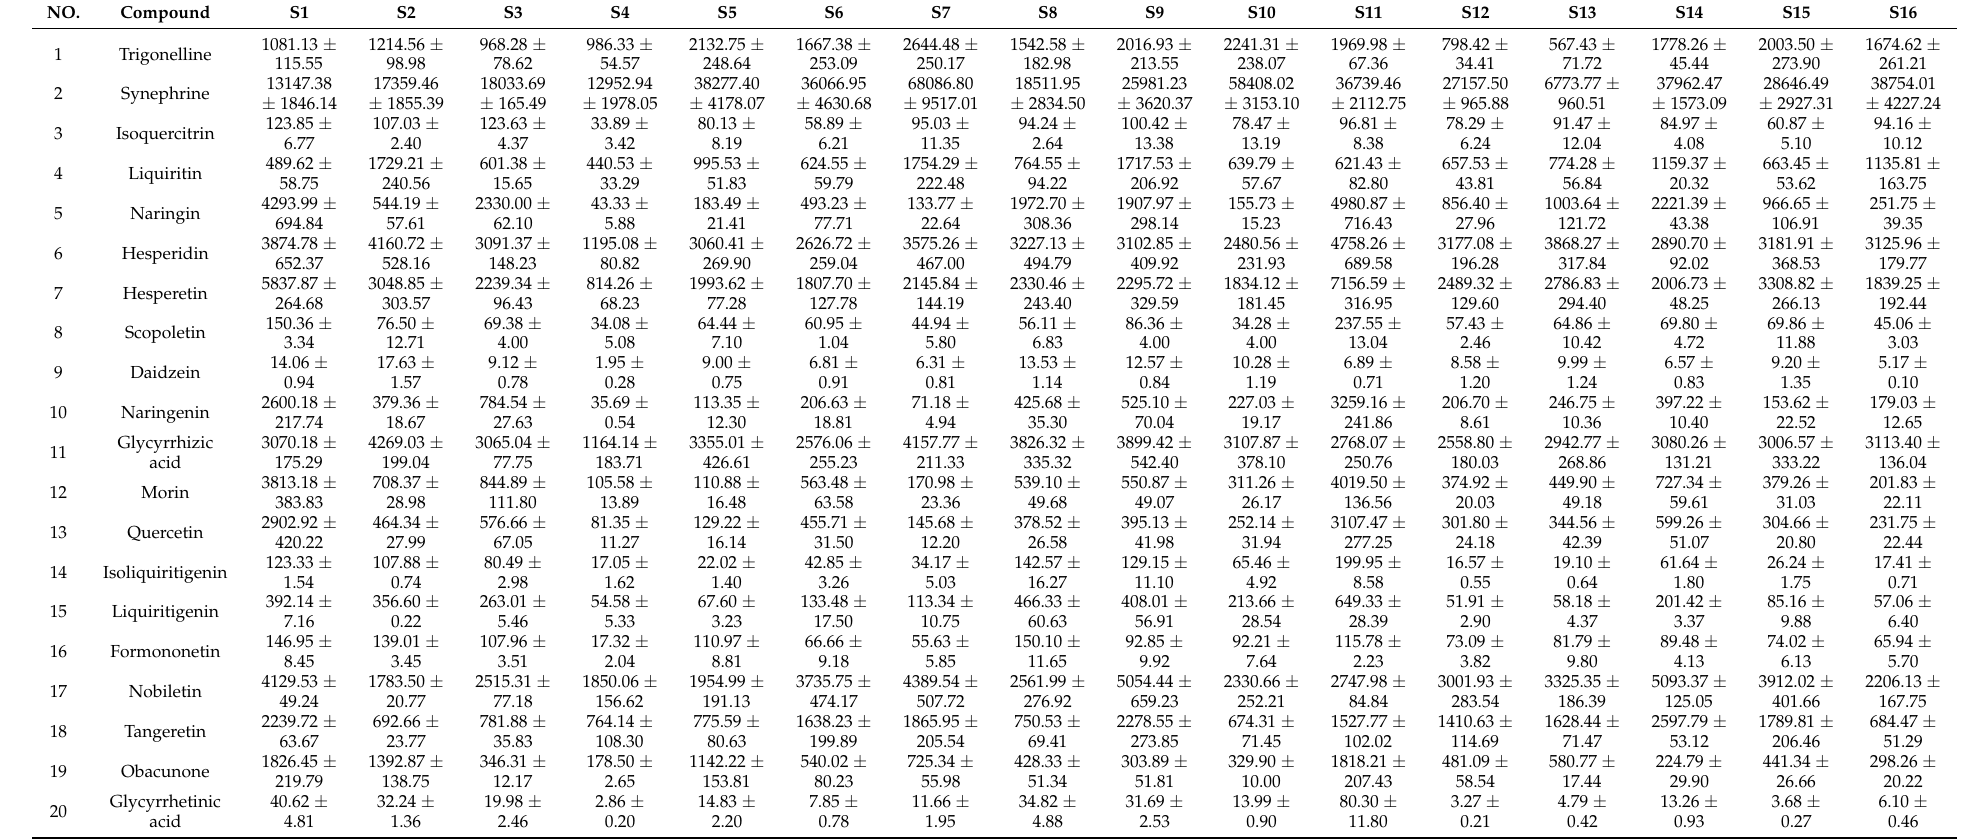
Table 2. The mean of the 20 chemical contents of WDD ( n = 3, µ